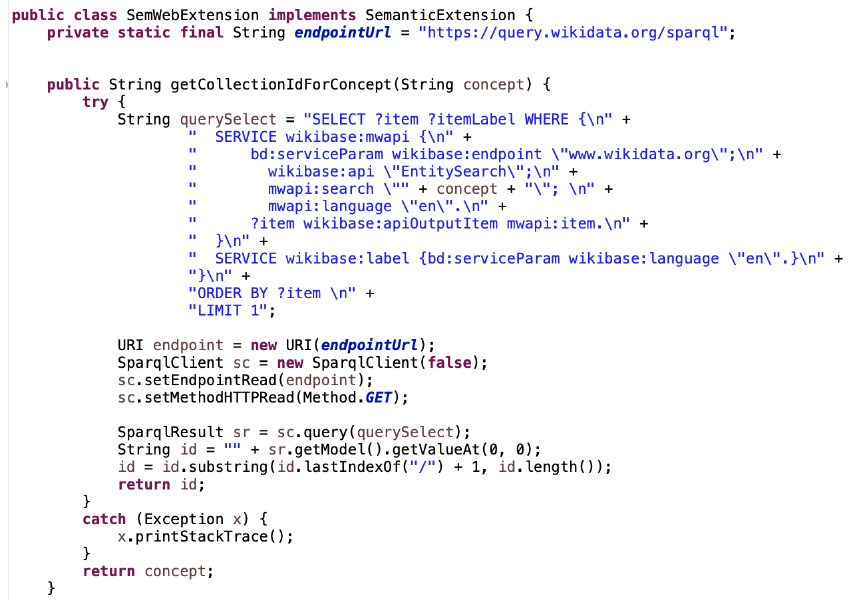
Figure 11. Querying an external semantic system for unique IDs with